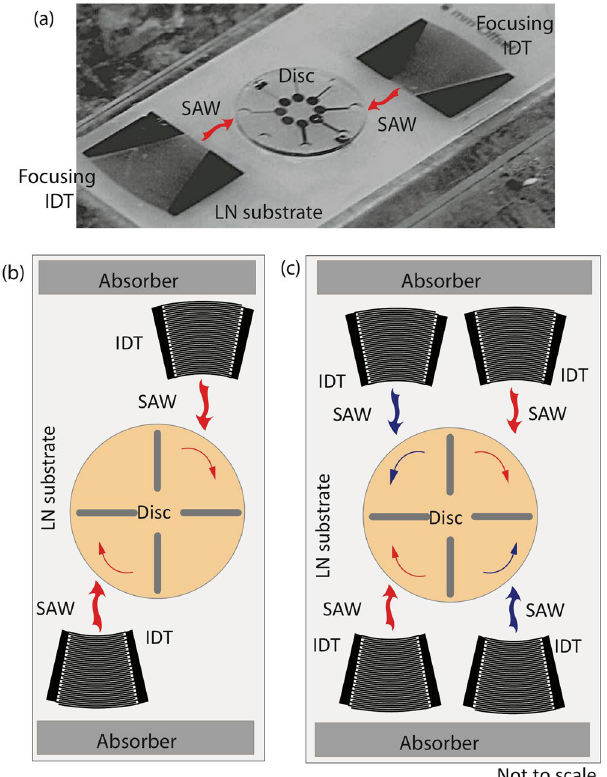
Figure 1. ( a ) Image (reproduced with permissions from ref. 7; © (2012) John Wiley & Sons, Inc.) and ( b ) schematic of the Miniaturised-Lab-on-a-Disc (miniLOAD) device. ( c ) A second pair of opposing offset IDTs are required in order to reverse the rotation direction of the disc. Although this is a possible solution, the range of disc dimensions that can be used for each device is extremely limited given that the IDT patterns on the substrate are fixed. Altering the disc size requires IDTs to be placed in different locations on the piezoelectric lithium niobate substrate, thus requiring a different